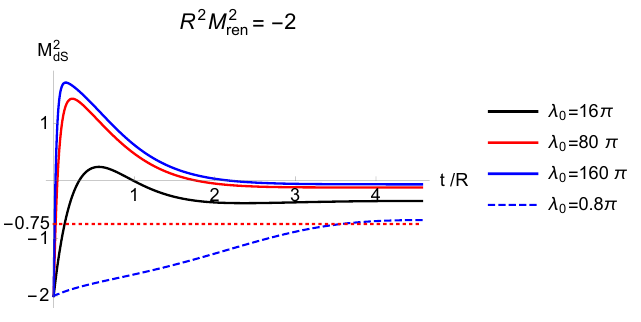
Figure 9 . The e(cid:11)ective mass M dS in dS-frame as a function of de Sitter time, for di(cid:11)erent values of the interaction strength and renormalized mass M 2